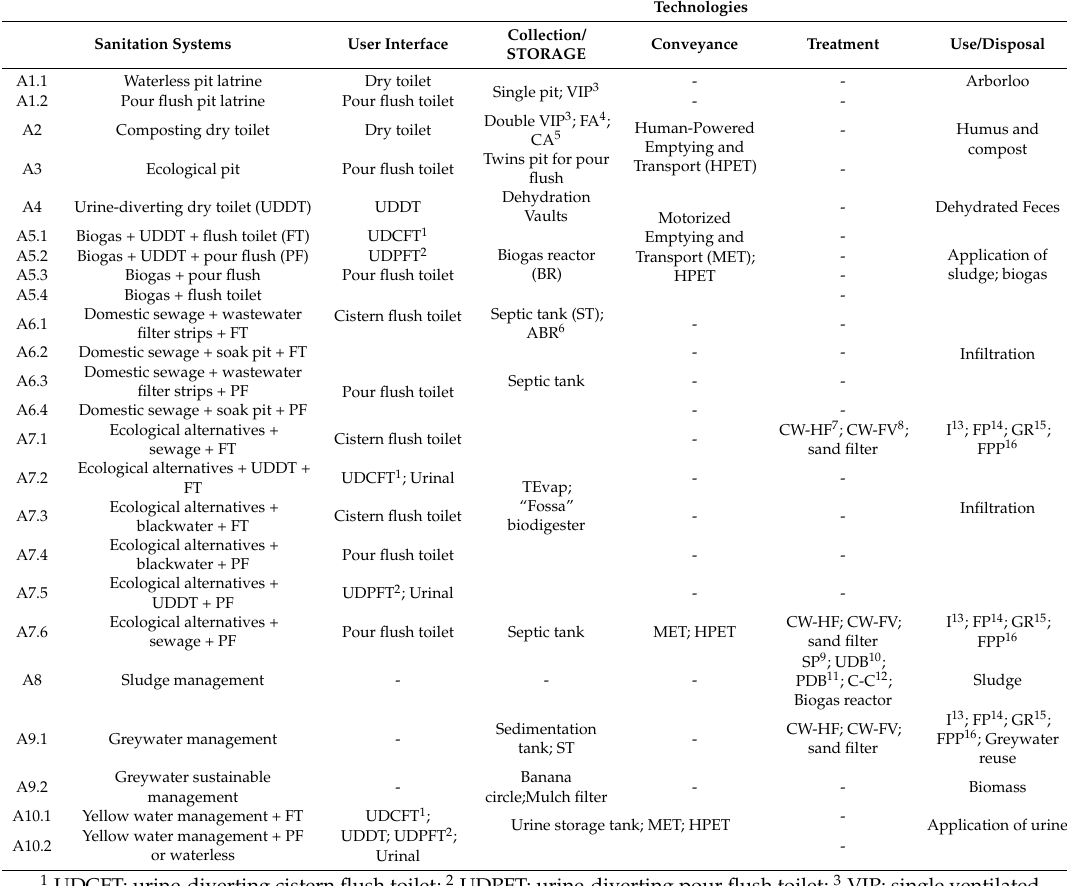
Table 2. Systems and technologies in database II (DB